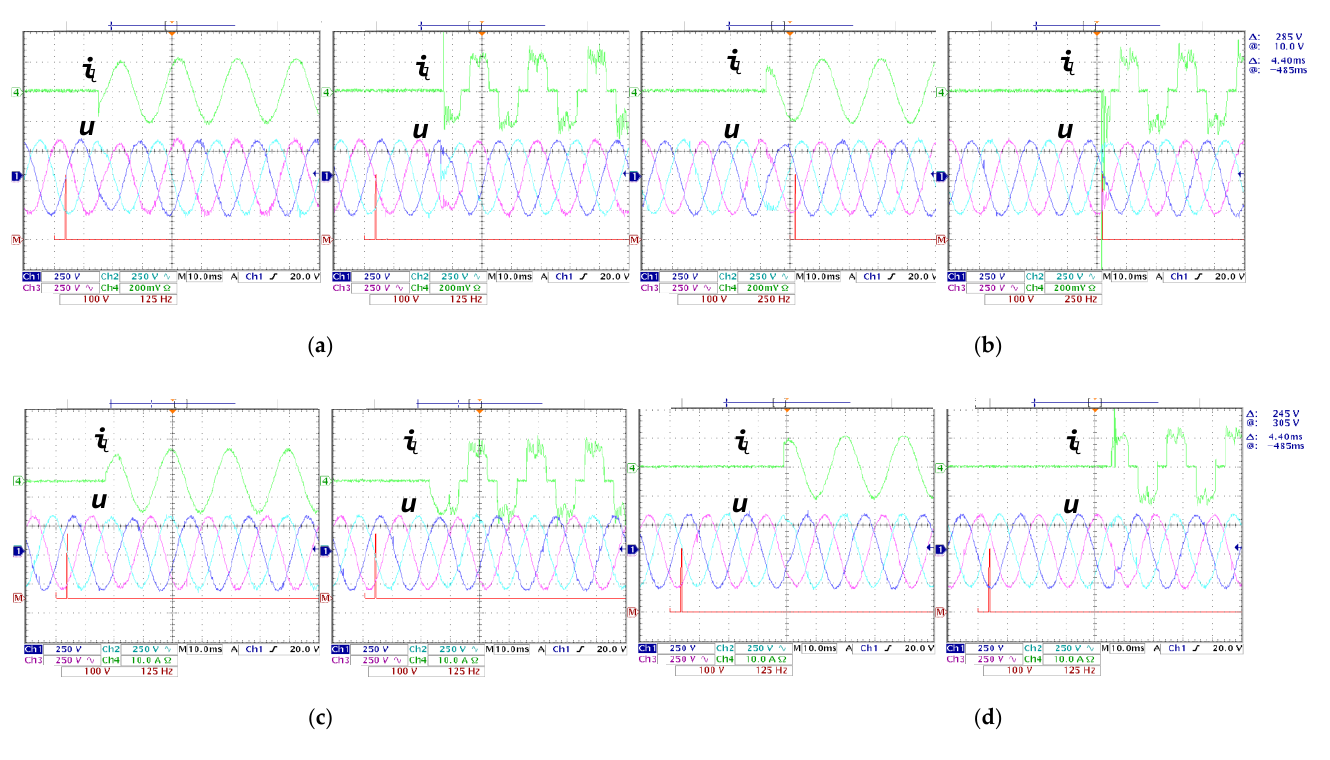
Figure 9. Dynamic waveforms of the proposed optimal control law with different LC filter parameters: Table 4. Performance comparison of the three control methods for output voltage.